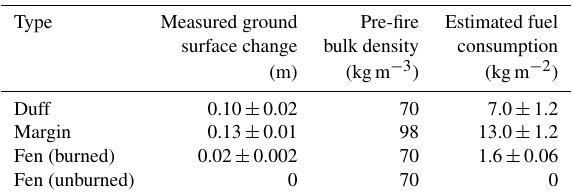
Table 4. Average ( ± SE) surface change and fuel consumption in upland, margin, and fen at Poplar